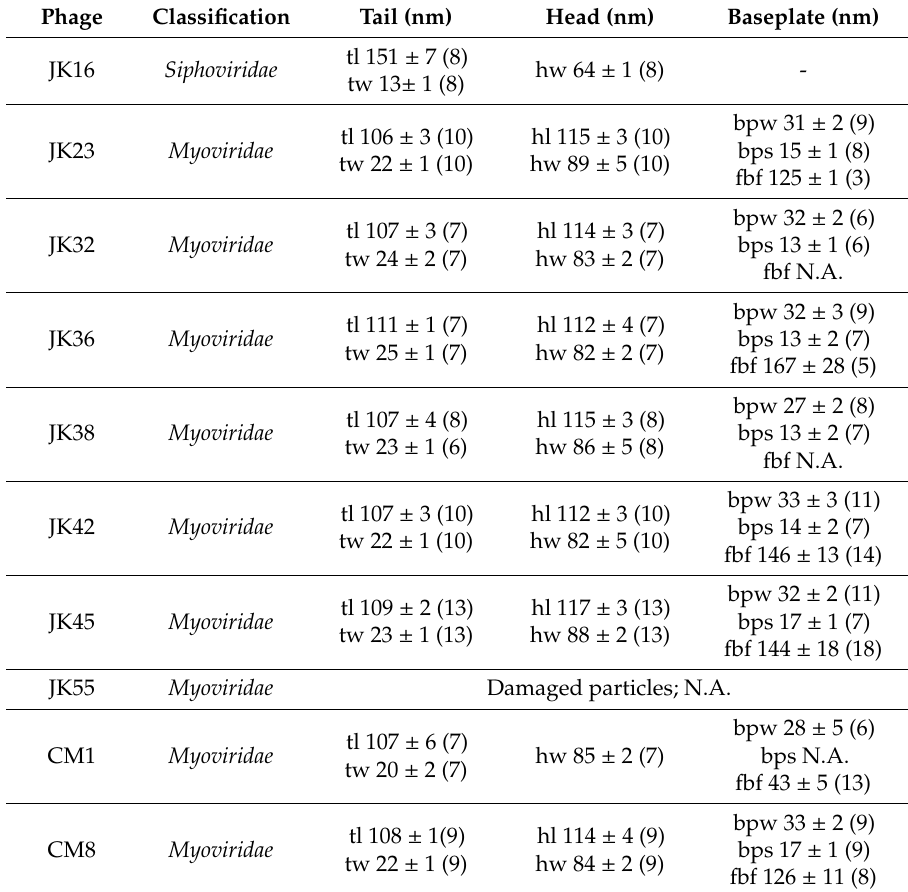
Table 2. Morphologies of the selected phages and measurements of the particles; Abbreviations: tl - tail length (incl. baseplate), tw - tail width, hl – head length, hw – head width, bpw – baseplate width, bps – baseplate spikes length, fbf – free baseplate fibers length; the number of measured phages is stated in brackets. N.A. – the measurement is not